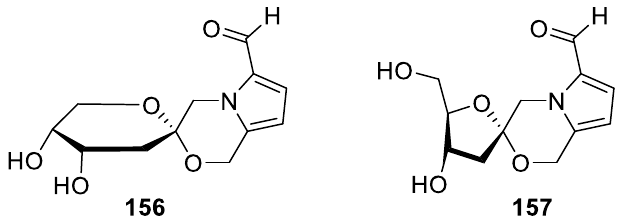
Figure 72. Pollenopyrroside A isolated from bee-collected Brassica campestris pollen.